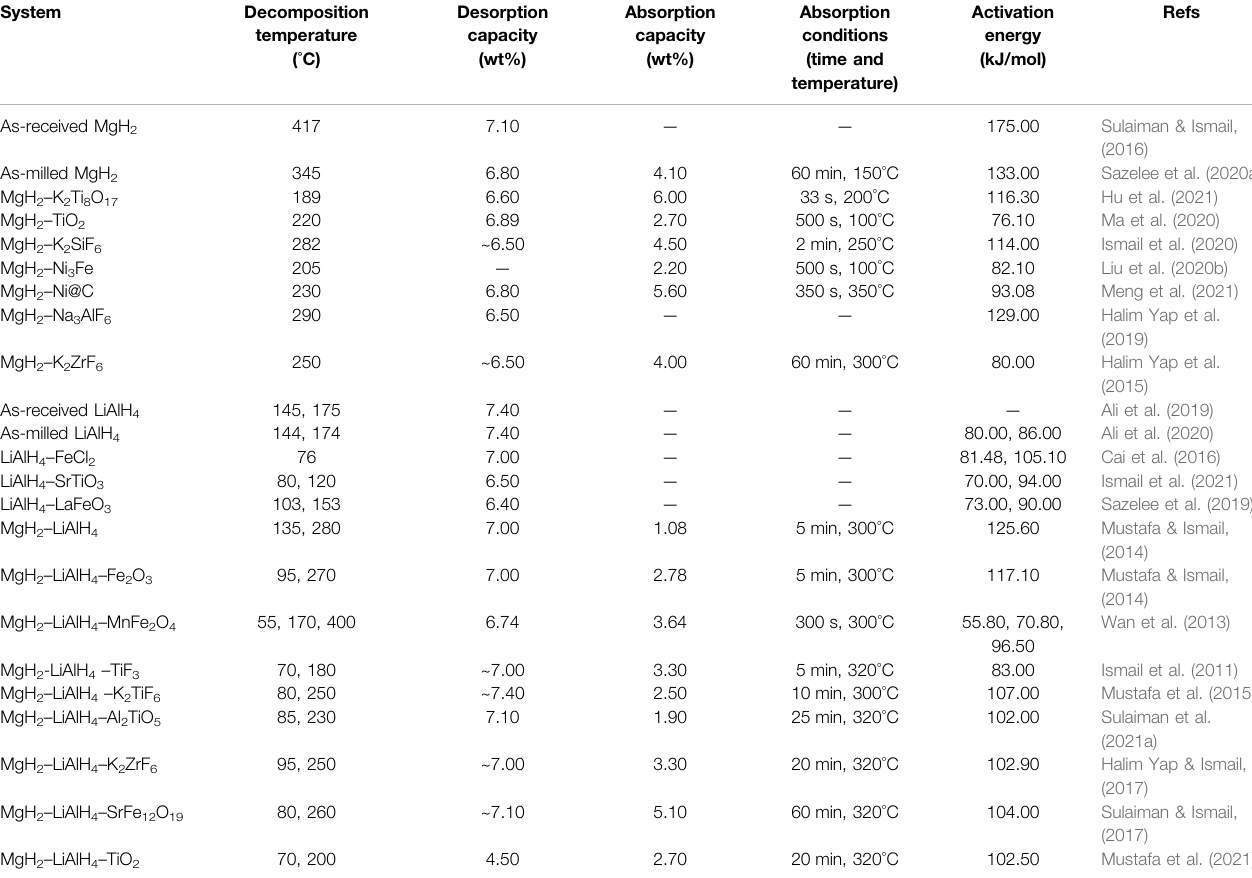
TABLE 5| Hydrogen storageperformanceofthe Mg – Li – Aldoped system with several additives compared with the undoped Mg – Li – Alsystemand unary MgH 2 and LiAlH 4